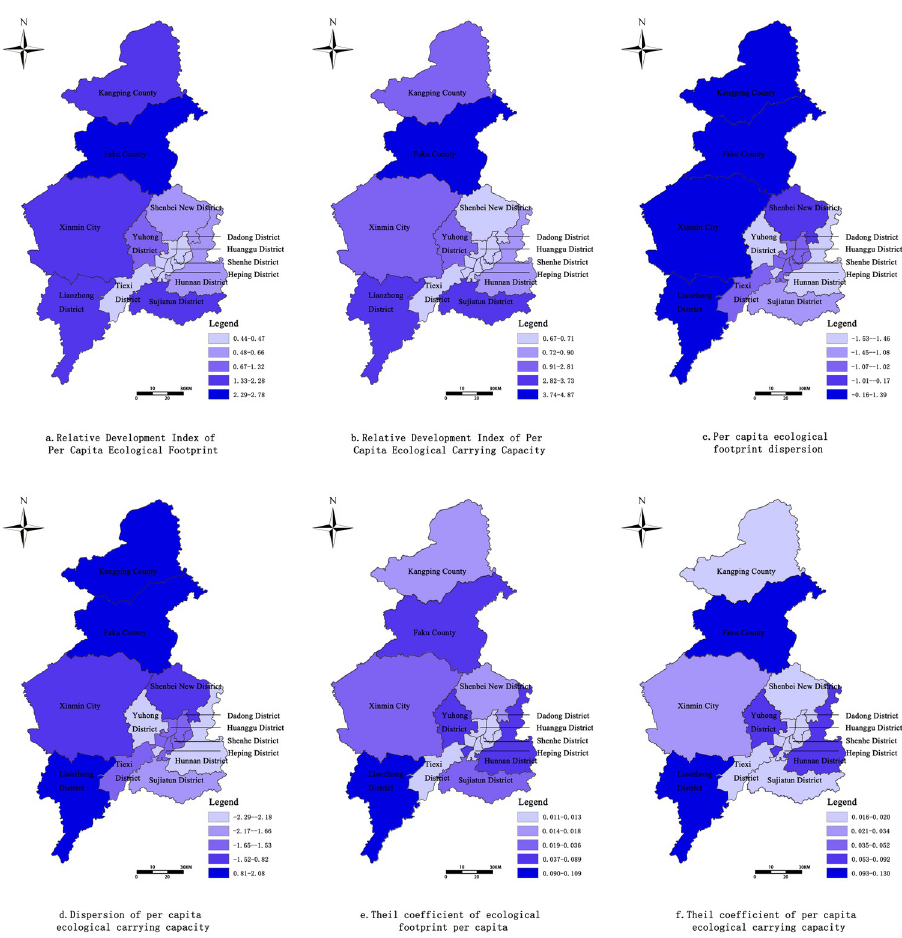
Fig 6. Ecological footprint per capita, relative development index of ecological carrying capacity per capita, deviation and Sill coefficient in Shenyang (2005–2019) (Image Source: https://www.naturalearthdata.com/ downloads/10m-cultural-vectors/). a. Relative Development Index of Per Capita Ecological Footprint. b. Relative Development Index of Per Capita Ecological Carrying Capacity. c. Per capita ecological footprint dispersion. d. Dispersion of per capita ecological carrying capacity. e. Theil coefficient of ecological footprint per capita. f. Theil coefficient of per capita ecological carrying capacity.